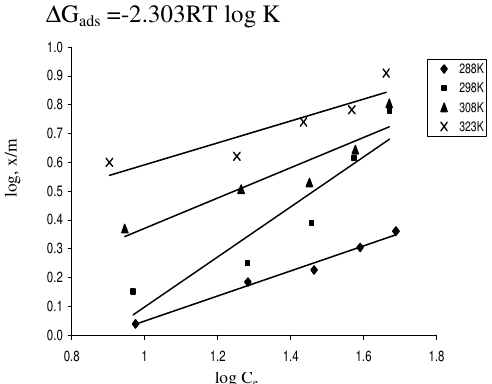
Figure 3. Freundlich isotherm for the adsorption of Zn 2+ by human